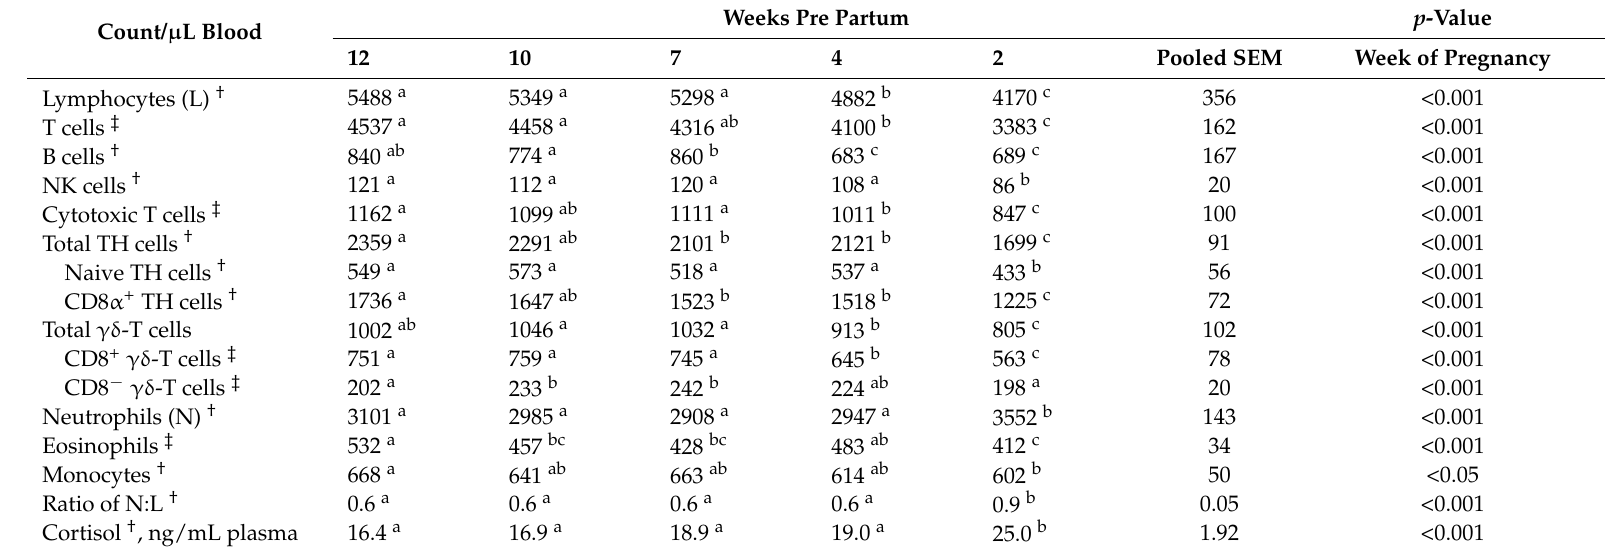
Table 2. Count of blood leukocytes and lymphocyte subpopulations in sows at defined weeks pre